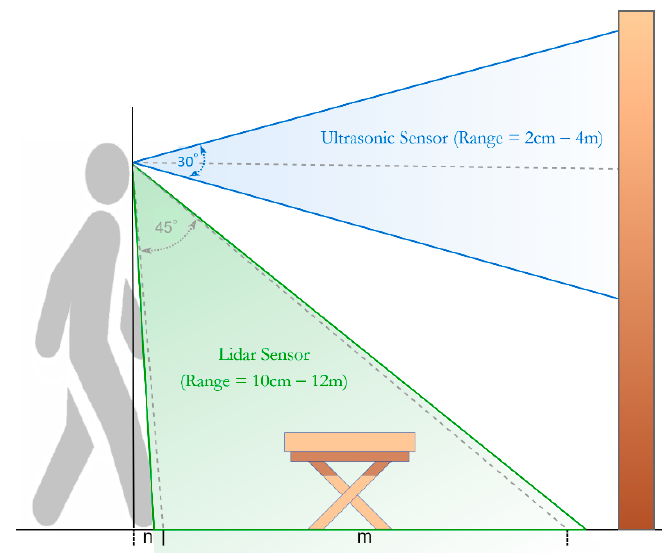
Figure 8. Ultrasonic and LiDAR sensor pulse direction and area.